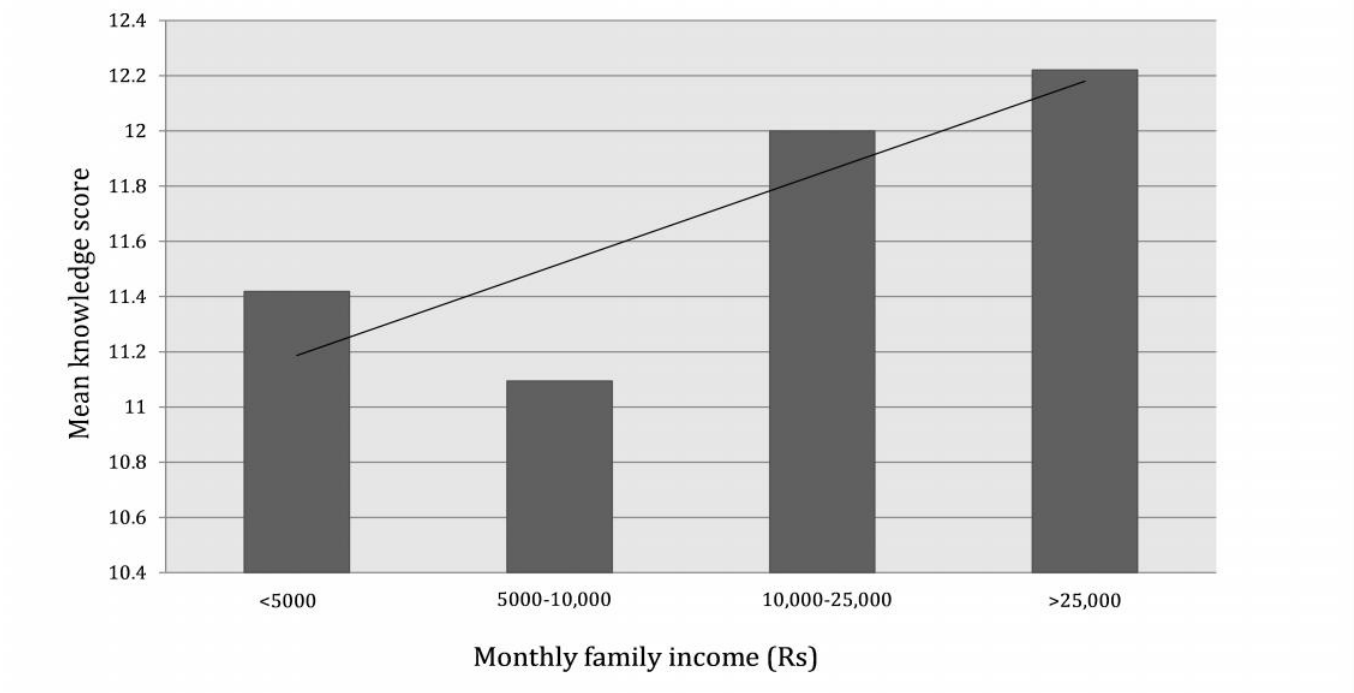
Figure 3: The correlation between mean knowledge score and monthly family